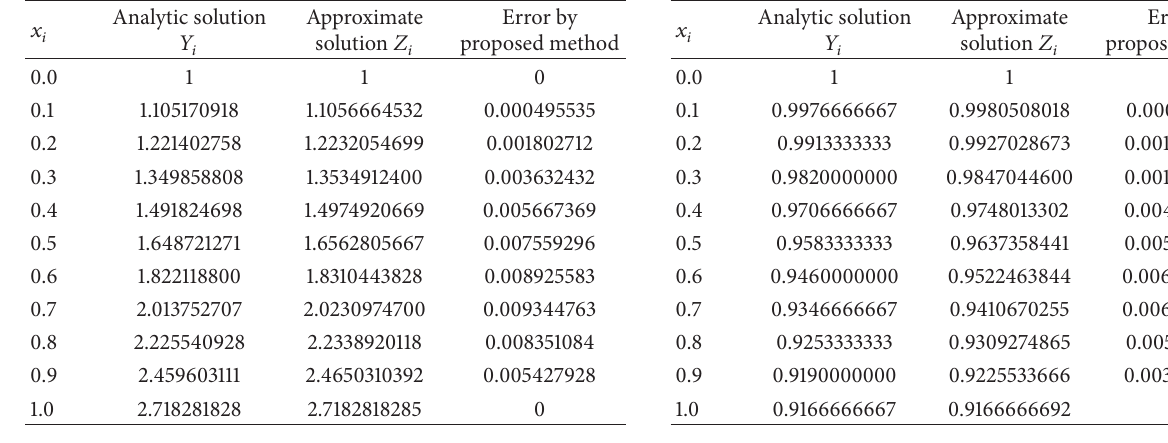
Table 6: Numerical results of Example 4: 𝑘 = 2 and ℎ = 10 −1 . Analytic solution 𝑥 𝑖 𝑌 𝑖